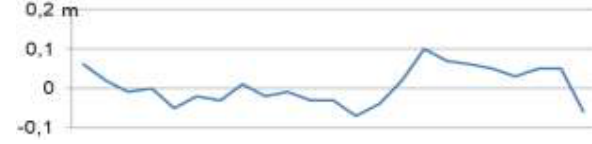
Figure 7. Averaged WV-4 y-parallax over 3 km in east-west